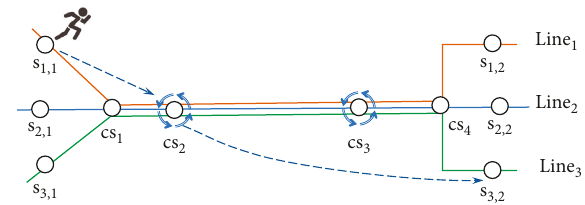
Figure 1: Passenger transfers at stops in an overlapping segment.